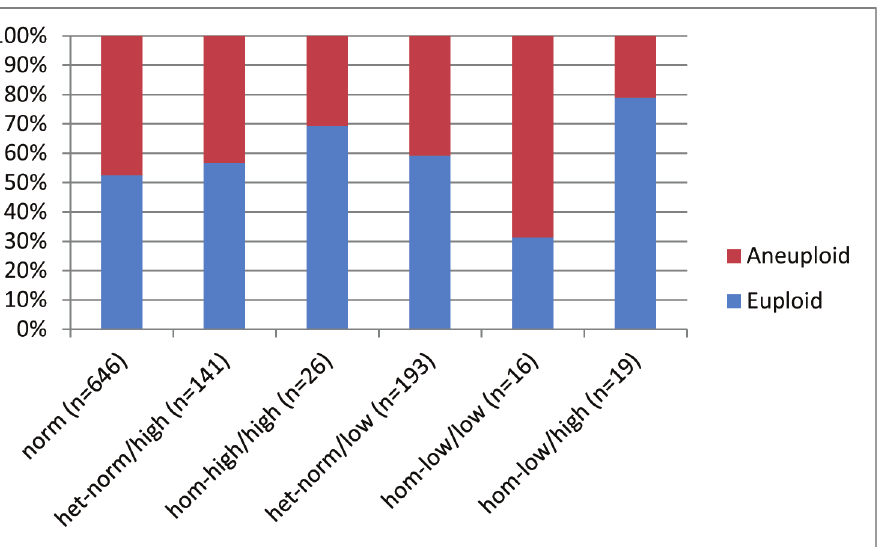
Figure 2. The distribution of embryo ploidy based on patients FMR1 sub-genotype. FMR1 mutations were not statistically associated with embryo ploidy, though the high aneuploidy rate in biallelic low , hom-low/low women is quite remarkable. Lack of significance may in here-reported findings, therefore, be consequence of small patient numbers. Also of interest is the very low aneuploidy rate in women with one low and one high allele, presenting with only approximately half the aneuploidy rate of even norm women. While these findings, dues to small patient numbers, also need to be viewed with caution, they could suggest a compensatory benefit from a high allele on negative effects of a low allele.